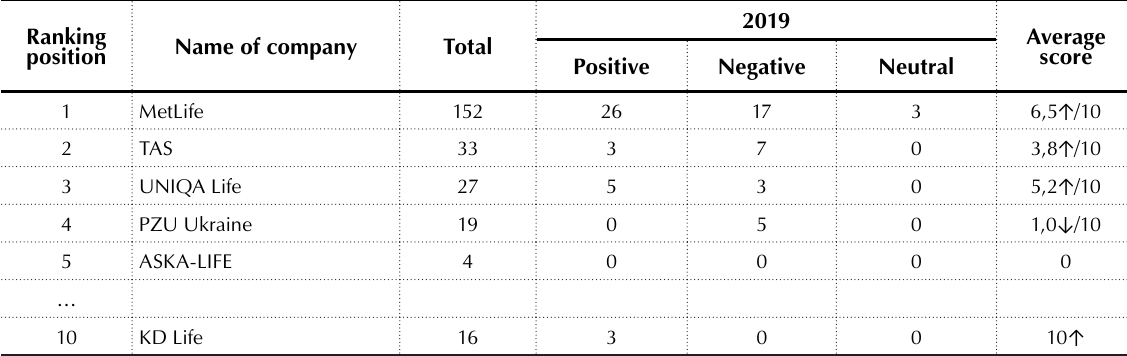
Table 8. Ranking of insurance companies’ PR activity “My insurance